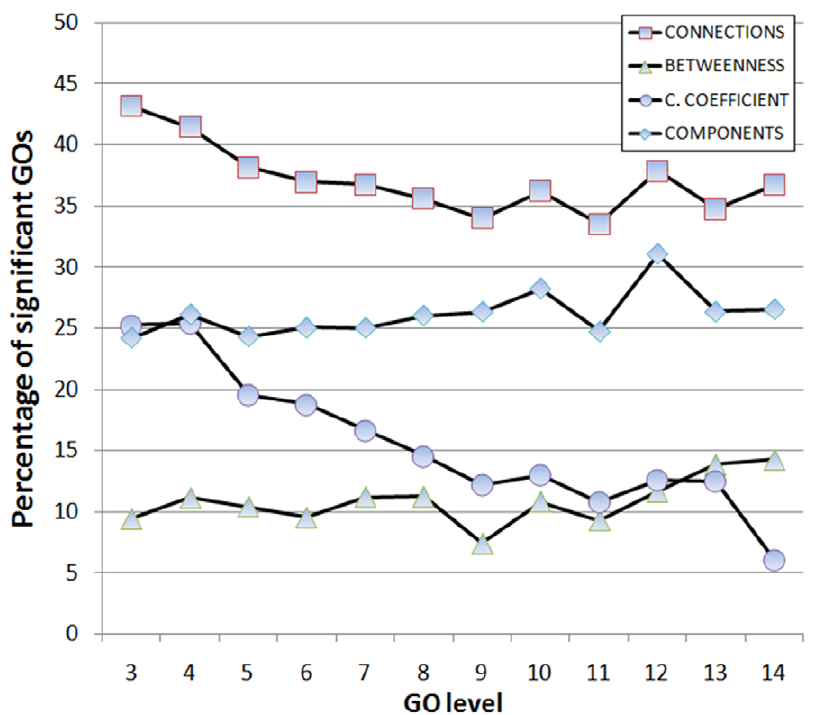
Figure 1. Relationship of different network properties with the GO level.